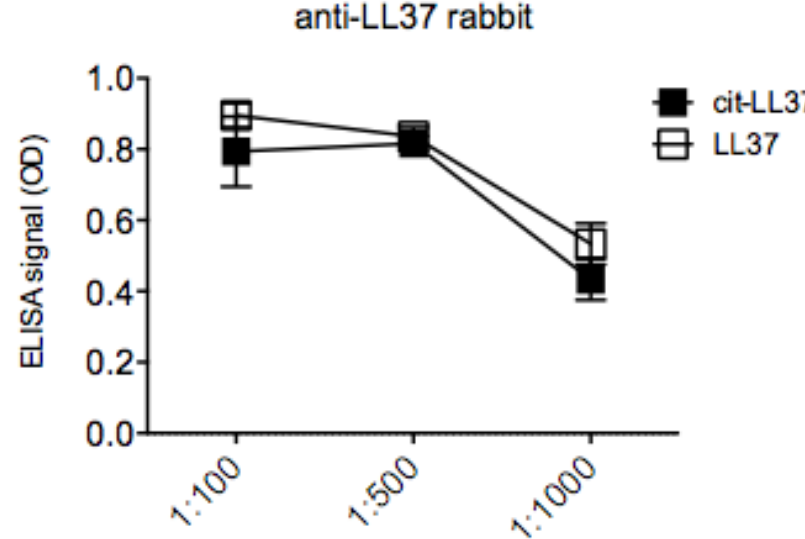
Figure 8. Polyclonal rabbit anti-LL37 does not discriminate between LL37 and cit-LL37 in ELISA tests. The rabbit polyclonal anti-LL37 (Innovagen) was diluted, as indicated, in ELISA plates coated with native LL37 or cit-LL37 peptides. Results are expressed as the mean of triplicate cultures. Standard errors of the means are indicated. Representative results form two independent